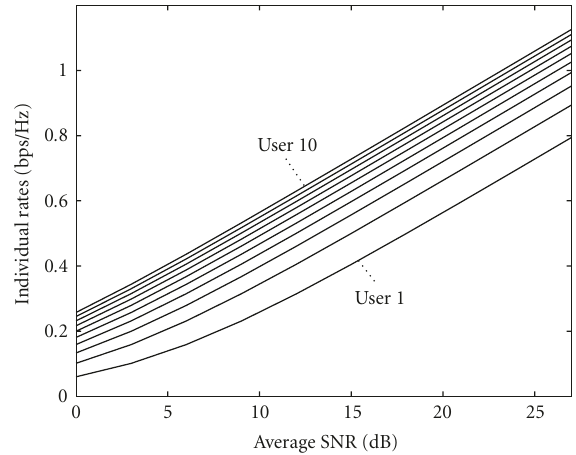
Figure 3: Individual rates for the 10-users channel using NSS.